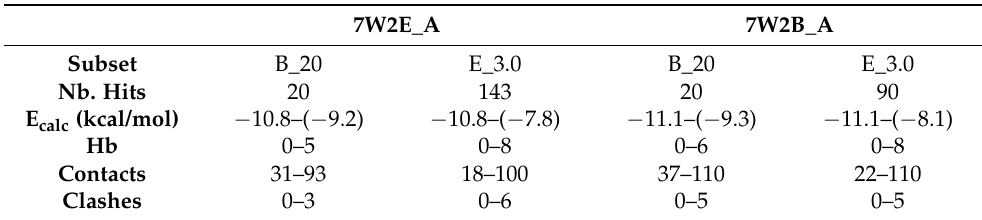
Table 3. Summary of the results of VS experiments against the 3D structures of Xl σ 1-R in coordinate files 7W2B and 7W2E. 7W2E_A and 7W2B_A: monomer with chain ID “A” in coordinate files 7W2E and 7W2B, respectively. B_20, E_3.0, Nb. Hits, E calc (kcal/mol), Hb, Contacts and Clashes are as